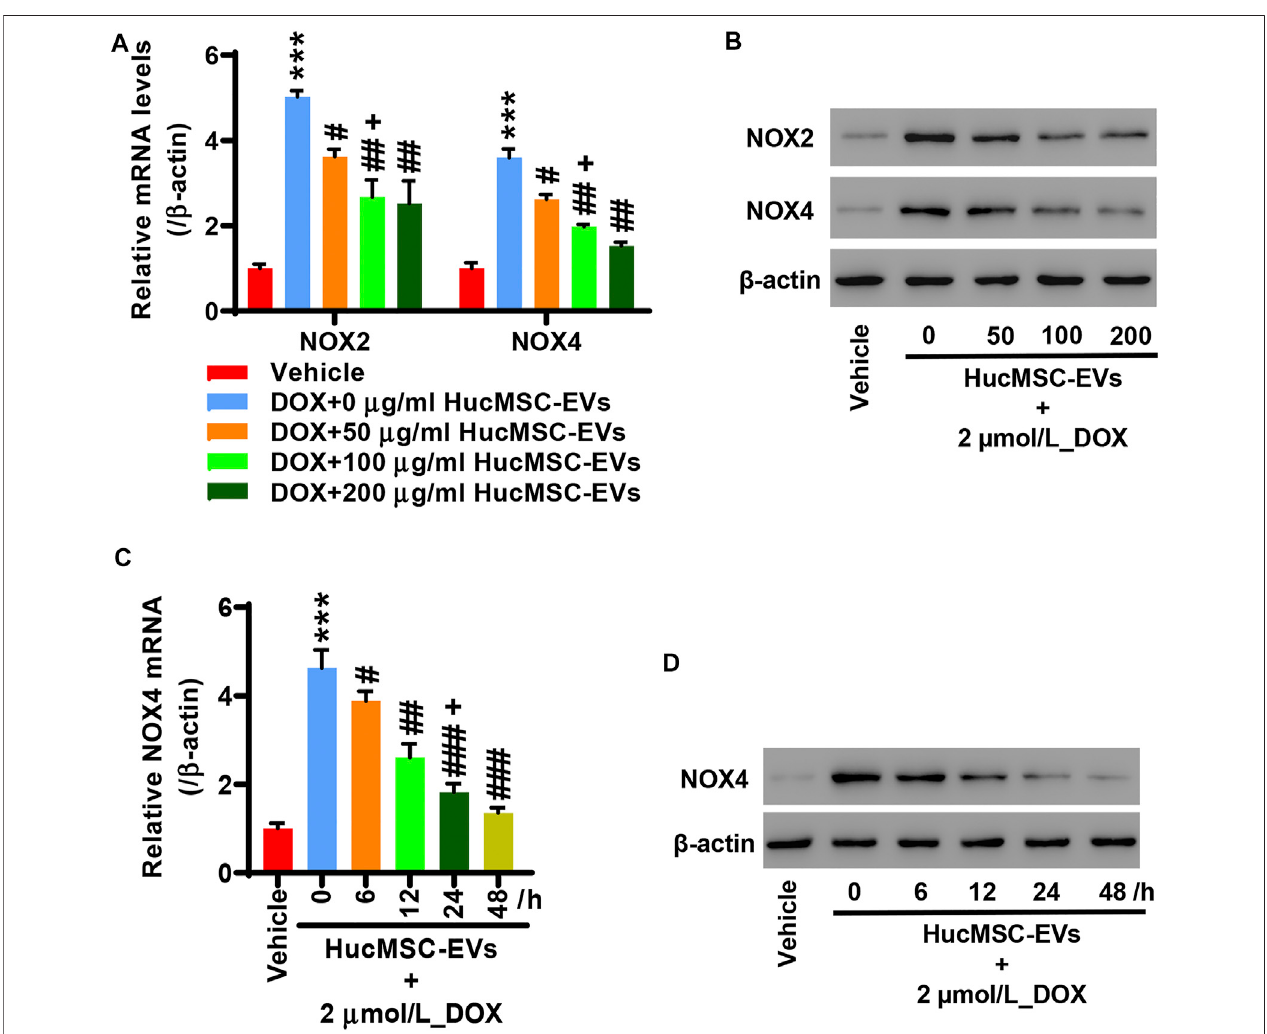
FIGURE 3 | HucMSC-EVs inhibits NOX4 expression. AC16 cells were treated with 2 µmol/L DOX and HucMSC-EVs at different concentrations (0, 50, 100, and 200 μ g/ml) for 24 h. (A) qRT-PCR and (B) Western blot were performed to detect NOX2 and NOX4 expression, respectively. *** p < 0.001 vs. vehicle, # p < 0.05, ## p